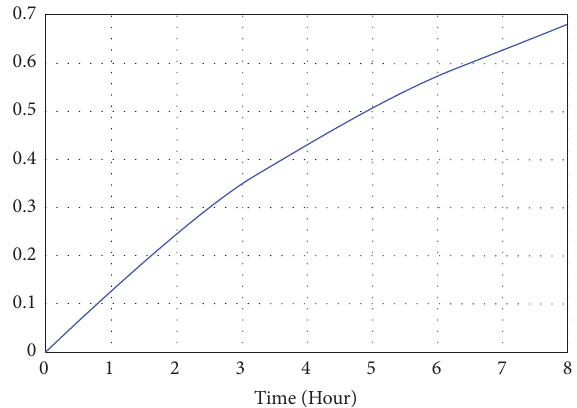
Figure 2: Workers’ stress when there is no rest time or lunch hour during work.